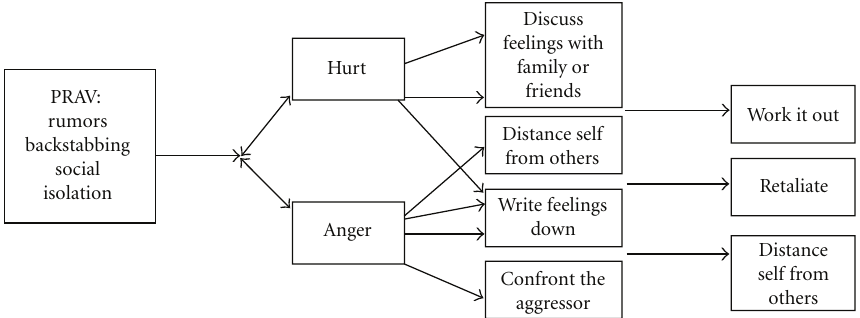
Figure 1: Theory of coping after experiencing peer relational aggression